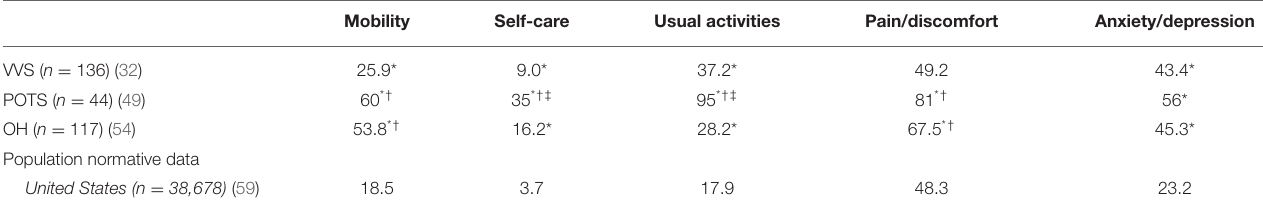
Mobility Self-care Usual activities Pain/discomfort